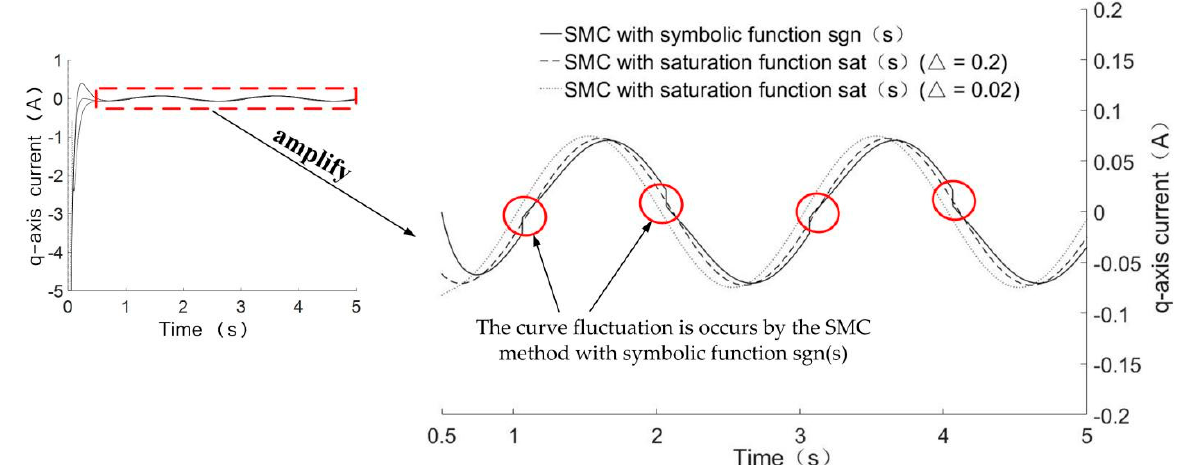
Figure 5. The fluctuation curves of q-axis current by different SMC methods.